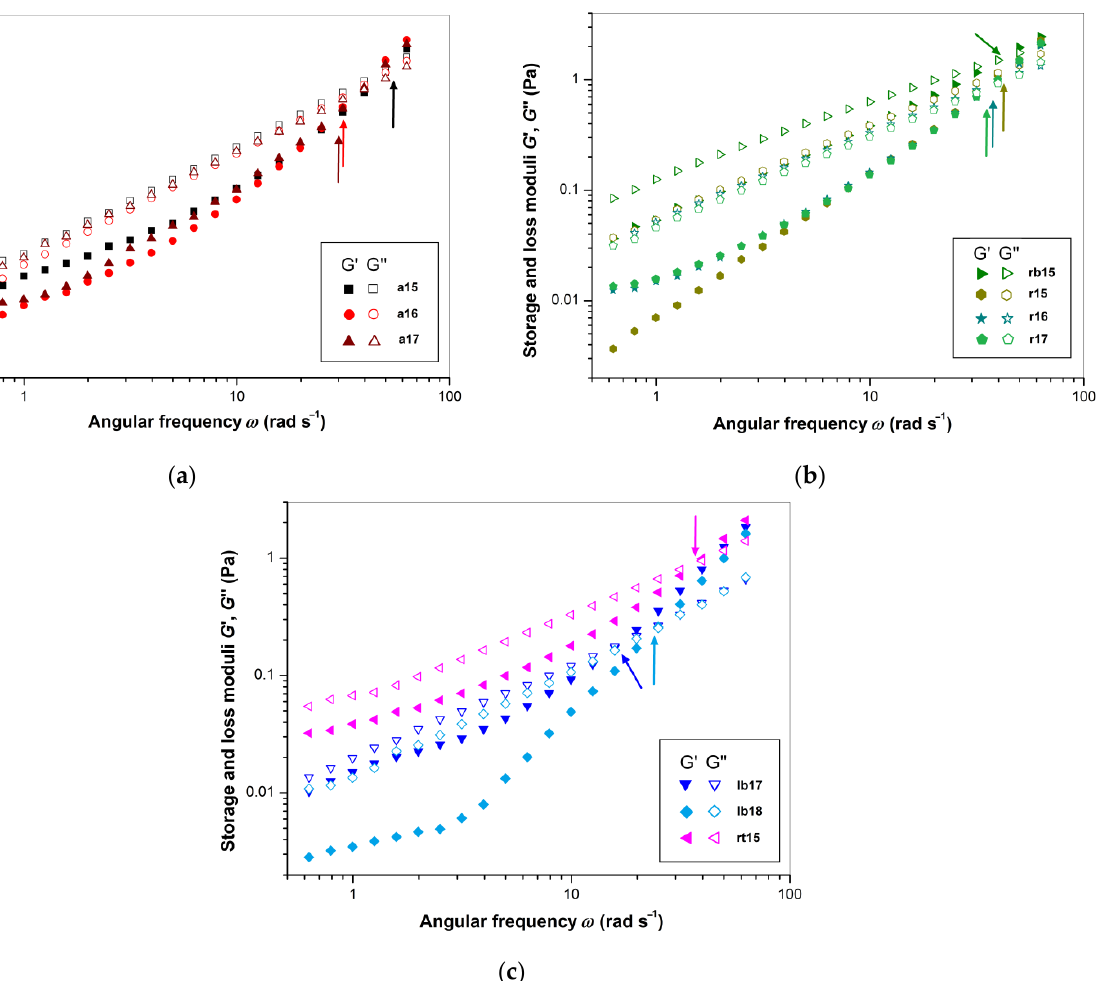
Figure 3. Dependences of the storage and loss moduli G ′ and G ″ on the angular frequency ω (on a double logarithmic scale) for the FSM samples in 1% aqueous solutions: ( a ) the Amon cultivar; ( b ) the Recital and Raciol cultivars; ( c ) the Libra Bio cultivar. The arrows point to the angular frequency ω c at the crossover of G (cid:48) and G (cid:48)(cid:48) curves ( G (cid:48) = G (cid:48)(cid:48) ). For all mucilages, the K (cid:48) values (~0.5–21.6 mPa · s n ) were significantly lower than the corresponding K (cid:48)(cid:48) values (~9.8–138.6 mPa · s n ). Furthermore, the K (cid:48) and K (cid:48)(cid:48) values were